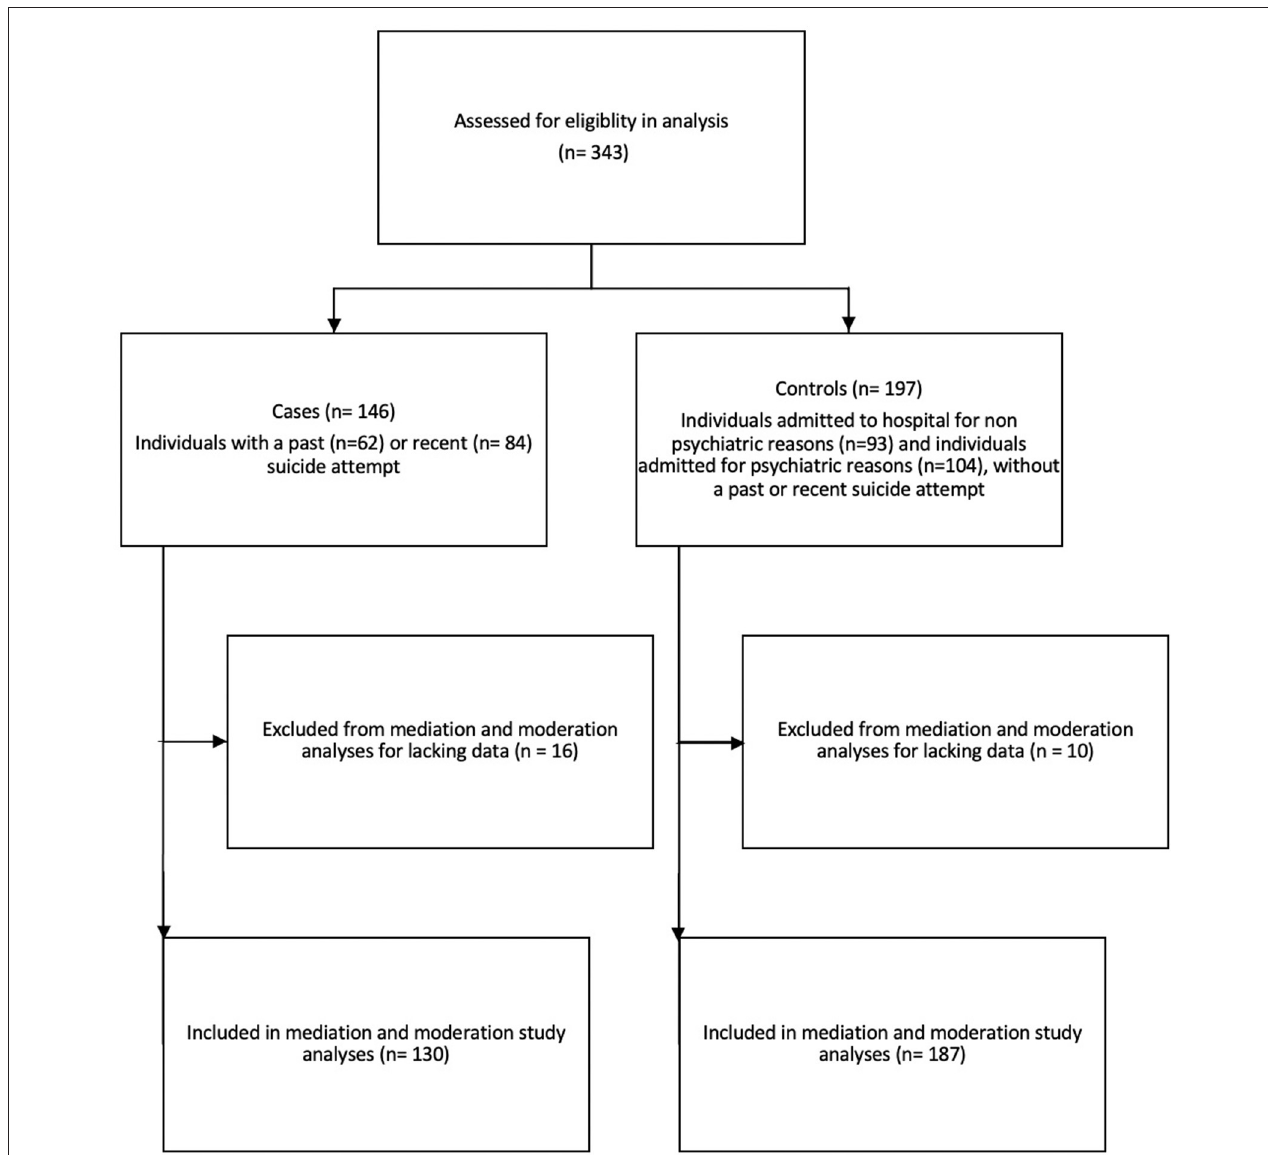
FIGURE 1 | Study flow